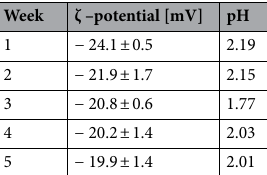
Table 2. ζ-potential and pH values of Au1 samples over the five-week experimental